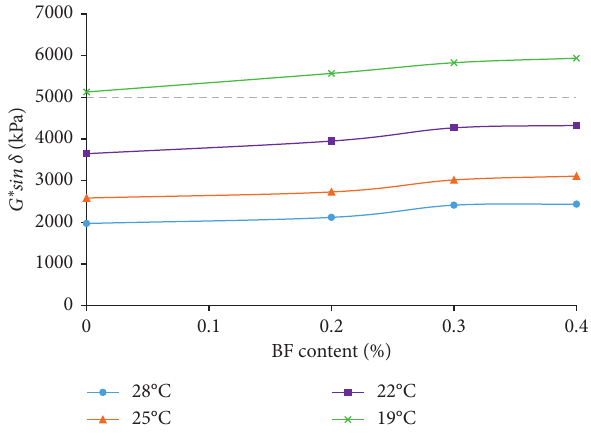
Figure 9: Fatigue property results.